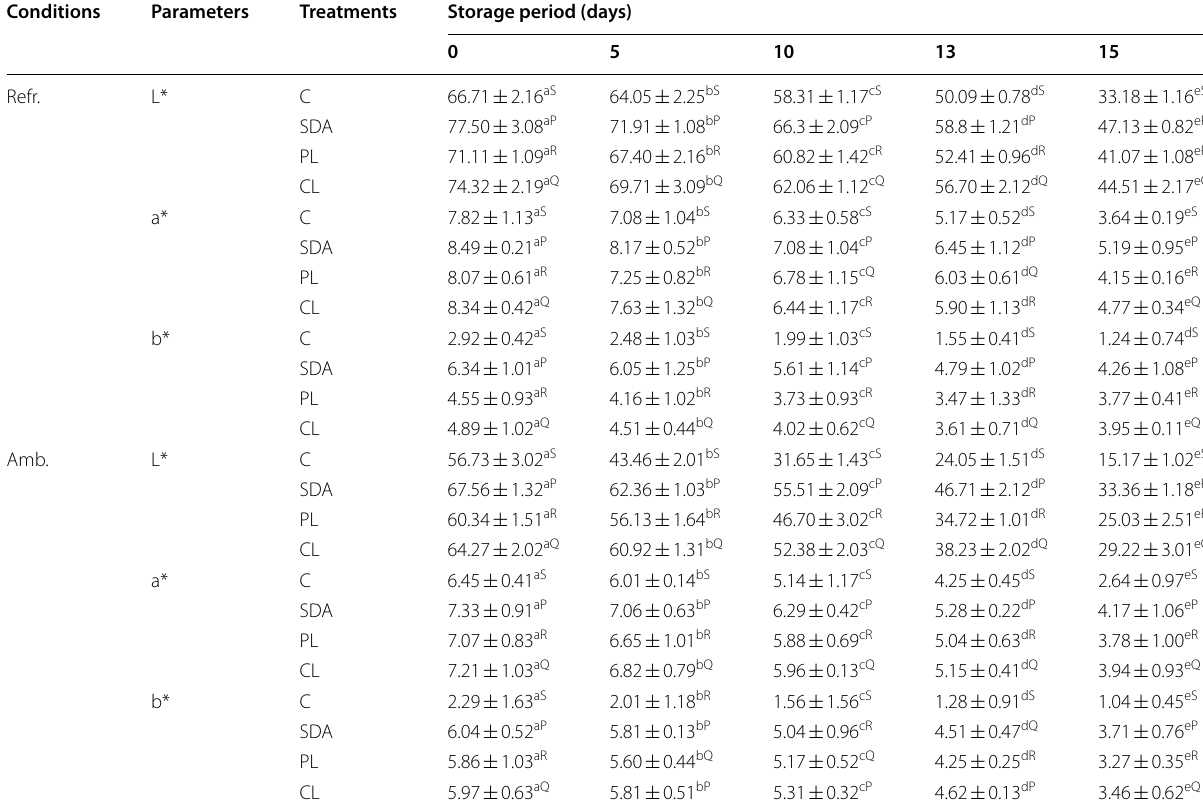
All values are mean standard deviation of three replicates ( n ± Values followed by the same letter in a row and in the column do not differ significantly ( p …’ within a column C: control; SDA: gravy treated with 0.25% sodium diacetate; PL: gravy treated with 2.5% potassium lactate; CL: gravy treated with 2.5% calcium